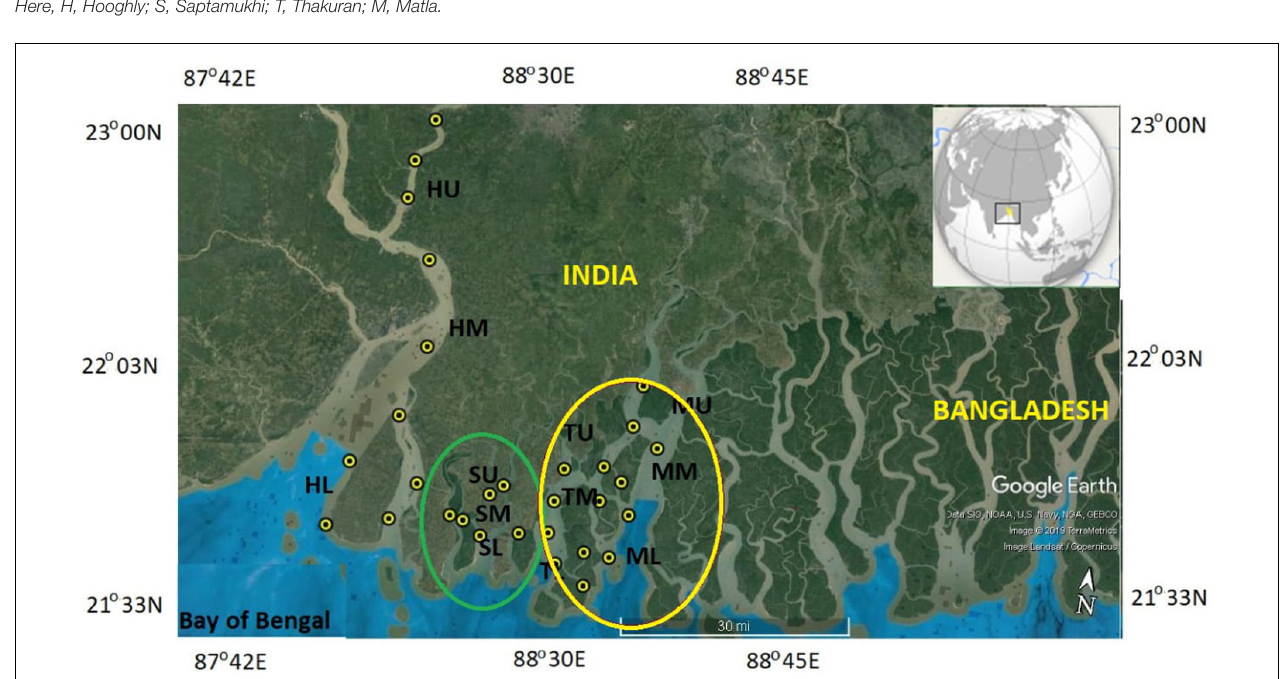
FIGURE 1 | Map of the sampling locations. Latitudes and longitude of many samplings sites overlapped while sampling at the similar points in different surveys (according to geographical positioning system), hence, they were not shown for clarity of the map. Upper (U), mid (M) and low (L) stretches of Hooghly (H), Saptamukhi (S), Thakuran (T), and Matla (M) are presented in the map. Yellow and green circles cover eastern plus central and western part of the Indian Sundarbans, respectively. Map was processed from the Google Earth